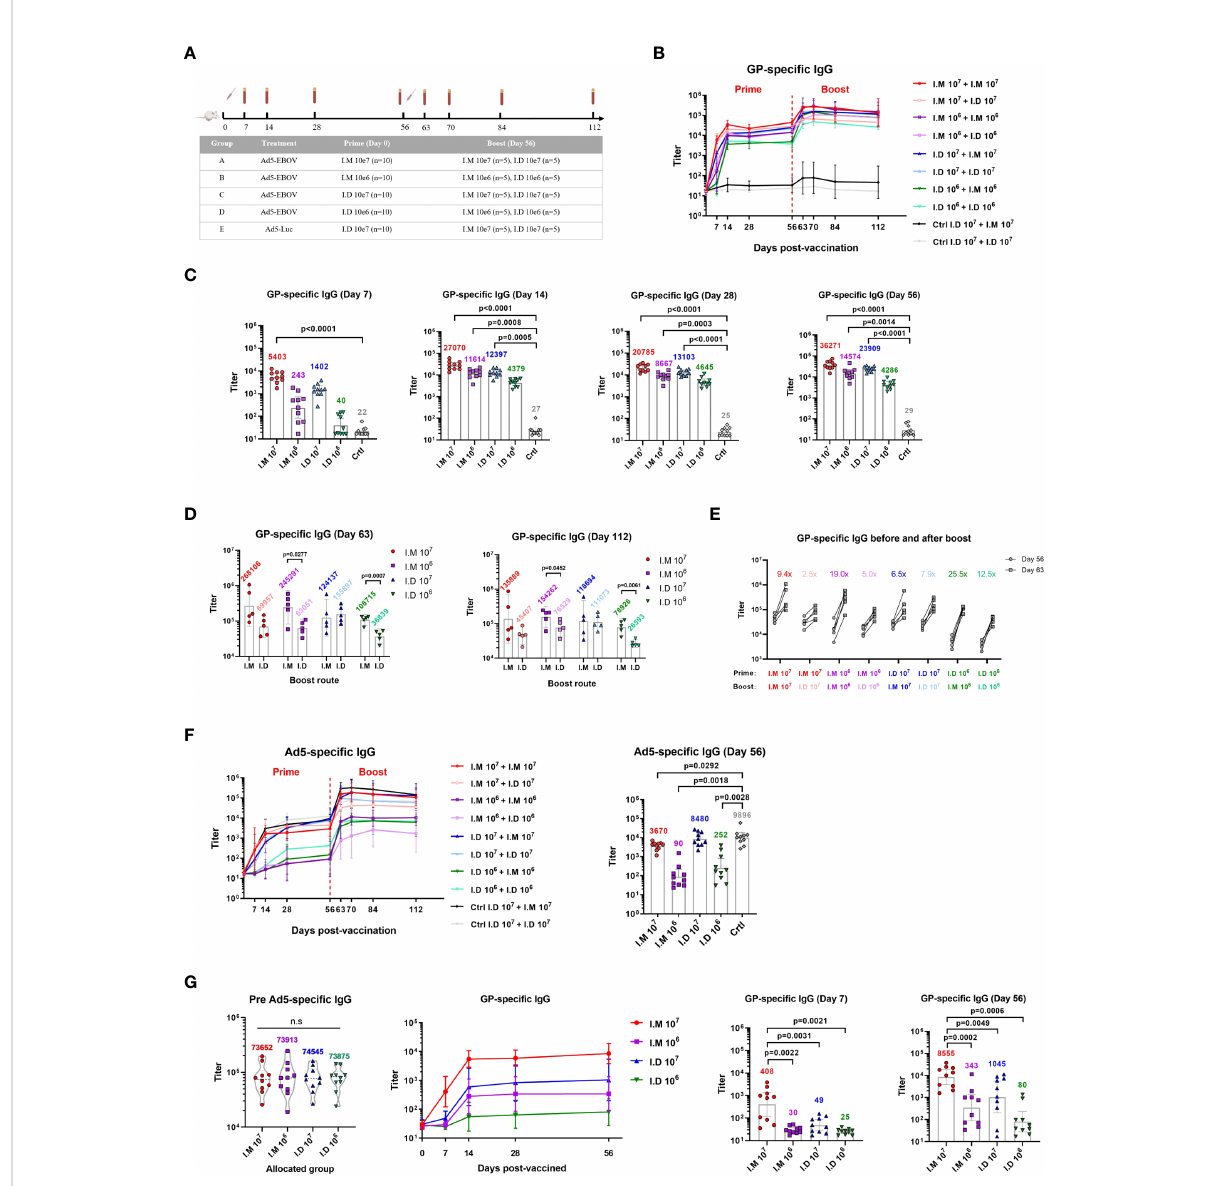
FIGURE 1 Intramuscular vaccination with Ad5-EBOV elicits a more robust humoral immune response than intradermal vaccination in mice. (A) BALB/C mice were primed and boosted at an interval of 8 weeks by intramuscular or intradermal routes. Blood was collected at indicated time points. (B) Overall GP-speci fi c IgG response. (C, D) GP-speci fi c IgG in serum was measured and compared on day 7, 14, 28 and 56 after the prime (C) and day 7, day 56 after the boost (D) . (E) Increase ratio (Day63/Day56) of GP-speci fi c IgG titer was calculated after the boost. (F) Overall